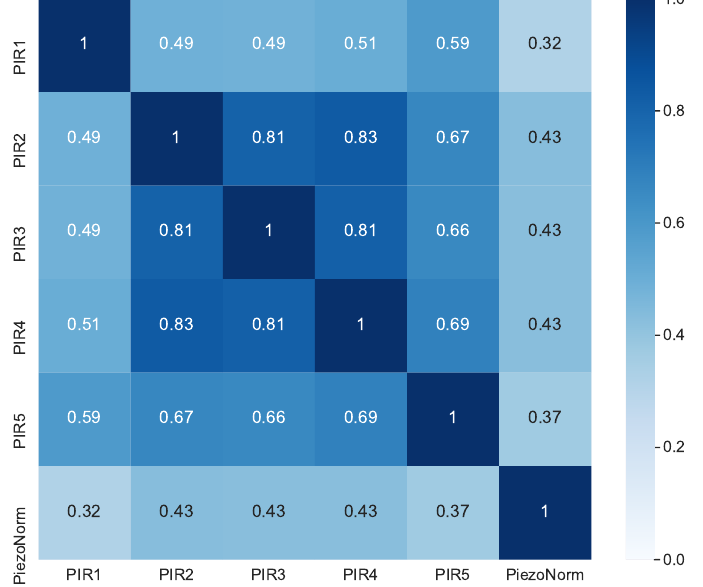
Figure 5. Correlation heatmap of the piezoelectric and passive infrared (PIR) sensors. Suppose that we consider a built-in delay in the PIR sensors and a highly oscillating output of the piezoelectric sensor, thus reducing the correlation. In that case, the calculated correlation is very promising. Post-processing of the data can partially eliminate these factors. The delay of the PIR sensors can be reduced by eliminating successive positive values in the time series. The piezoelectric signal oscillations can be ironed out using the sliding window method and then normalizing each event. Figure 6 shows the heat map, where the piezoelectric data were averaged using a sliding window of 100 samples or 3.3 s.